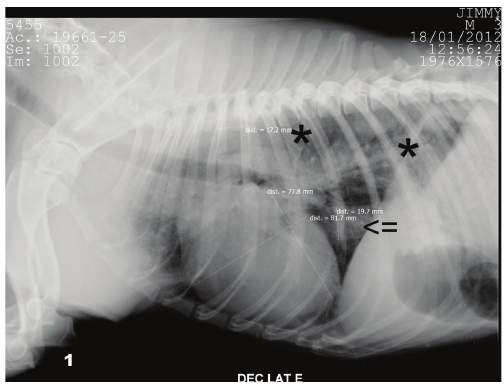
Figure 1: Lateral chest radiograph showing mild heart enlarge- ment, signs of pulmonary congestion and oedema ( ∗ ). The caudal vena cava ( < = ) is calibrous.